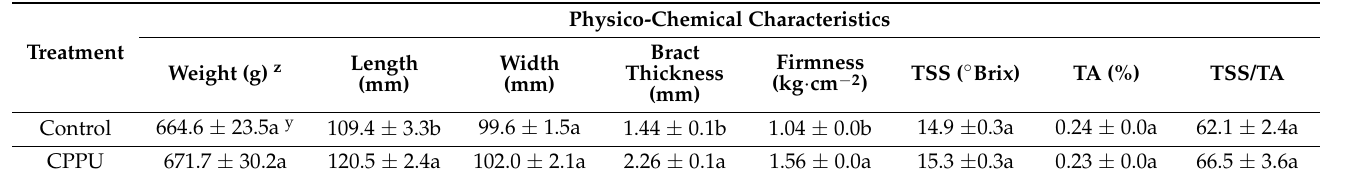
Physico-Chemical Characteristics